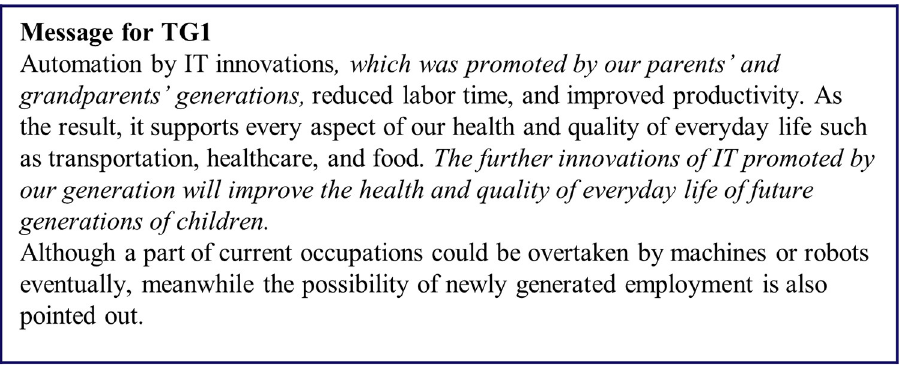
Fig 4. Messages presented to the TG1 group. Italic parts in the text are the intervention